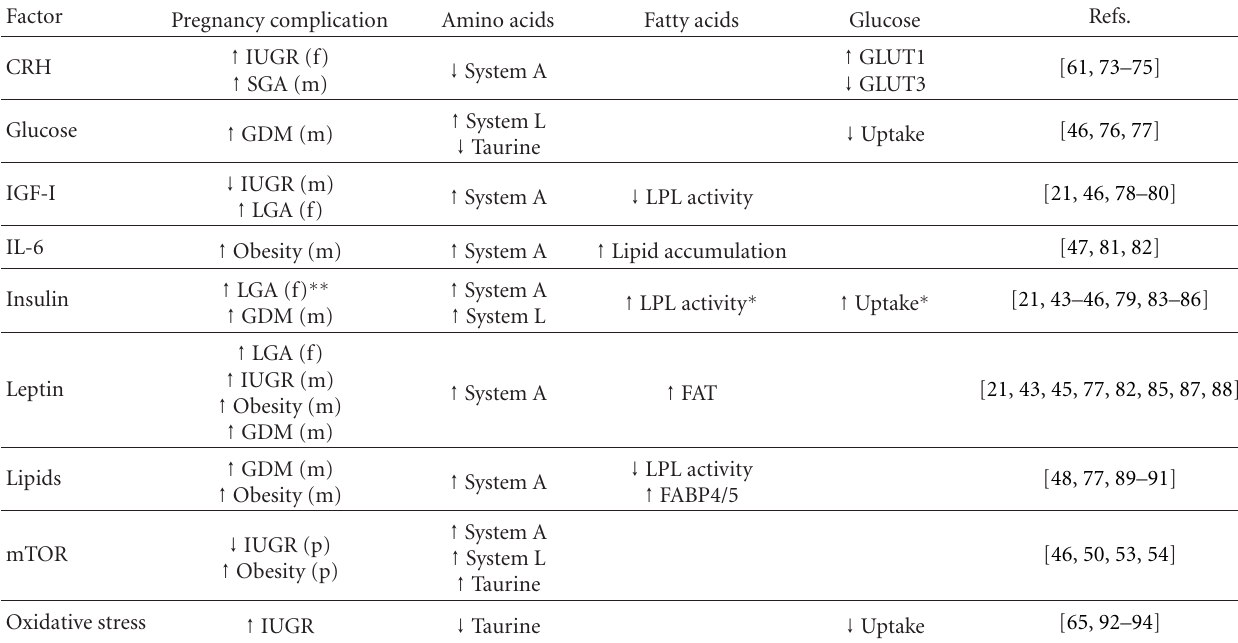
Table 2: Factors altered in pregnancy complications and their e ff ect on placental nutrient transport. Factor Pregnancy complication Amino